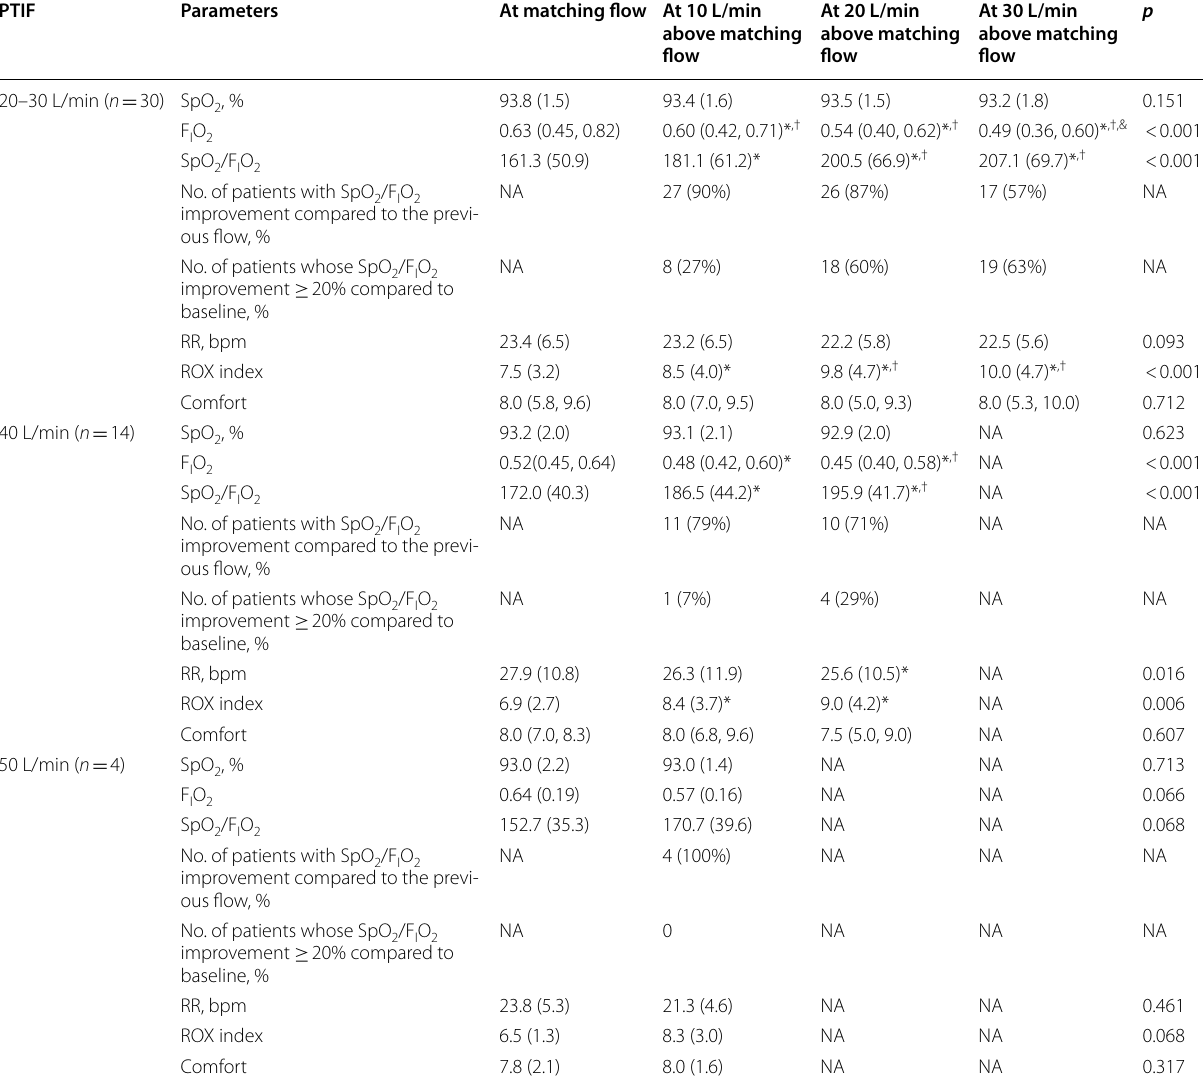
Table 2 Patient responses to HFNC flows set above their matching